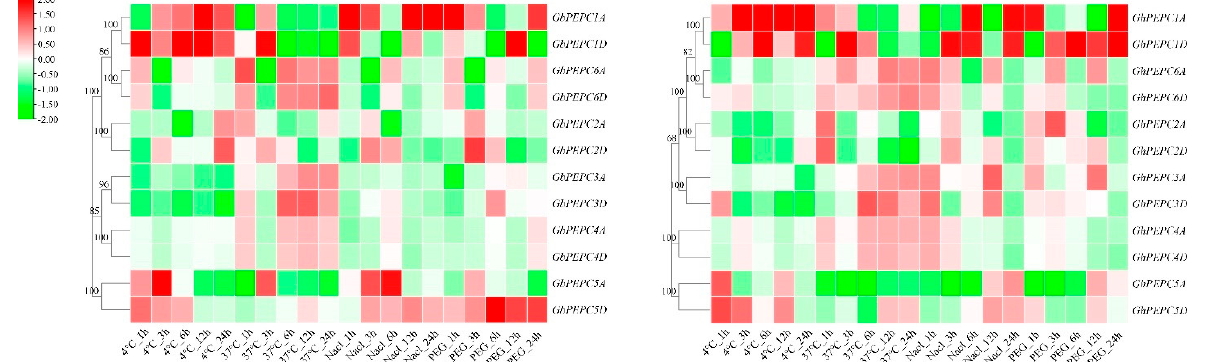
Figure 8. Expression profiles of the PEPC genes in response to different stresses. Value equal to Log 2 (treatment FPKM + 1)/(control FPKM +